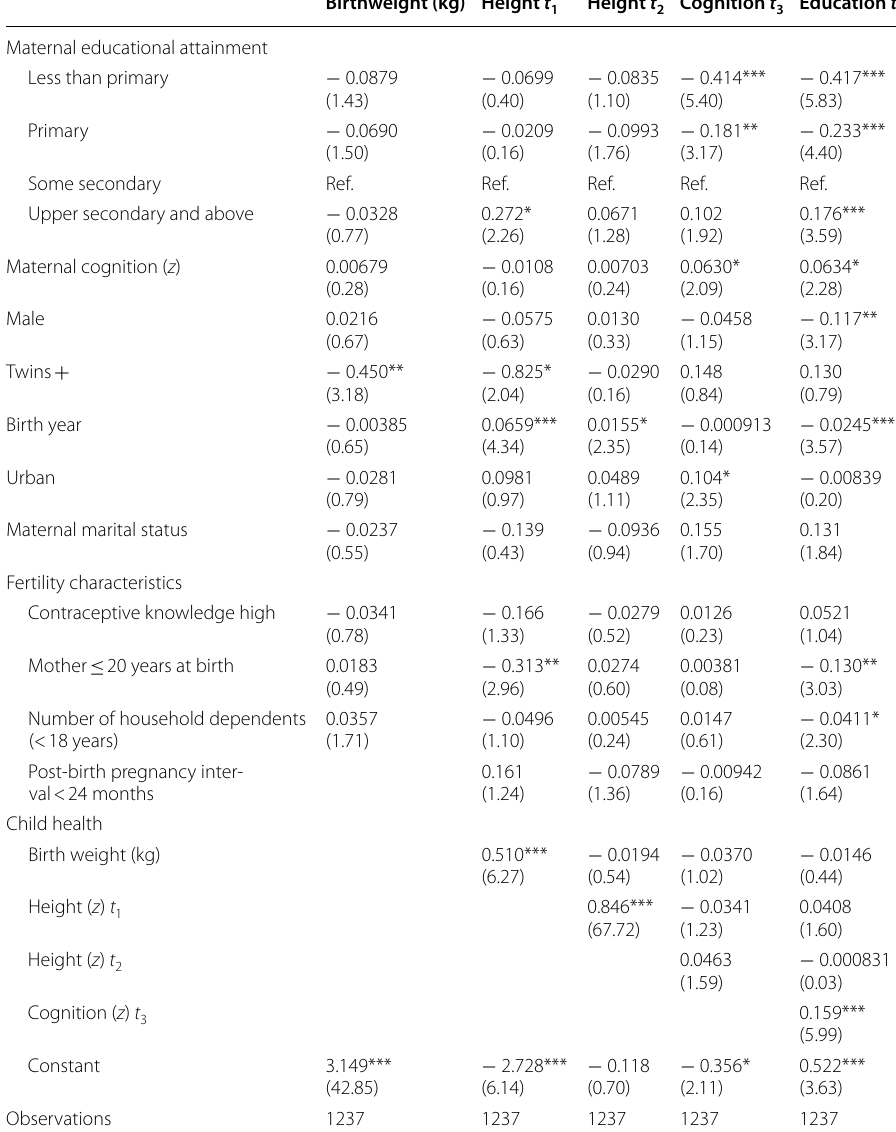
Table 2 Linear regression model coefficient estimates (standard errors) among first births Birthweight (kg) Height t 1 Height t 2 Cognition t 3 Education t